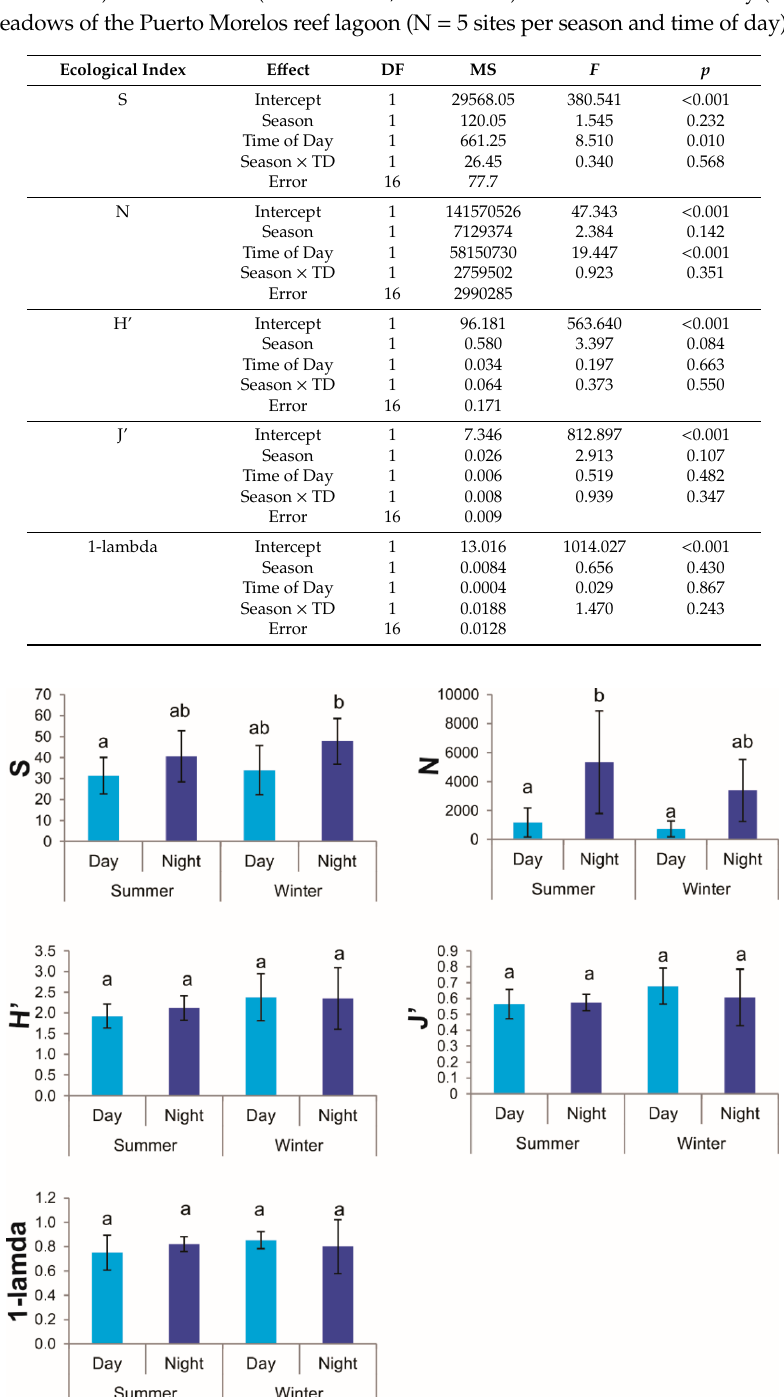
Figure 3. Mean ecological indices of decapod diversity (S: species richness; N: abundance; H’: Shannon–Wiener’s diversity; J’: Pielou’s evenness; 1-lambda: Simpson’s dominance) estimated in seagrass meadows of the Puerto Morelos reef lagoon during the day (light blue columns) and night (dark blue columns) in two seasons (summer 1995, winter 1998) (N = 5 sites per time of the day and season). Error bars are 95% confidence intervals. In each panel, the same letter indicates similar means ( α = 0.05).